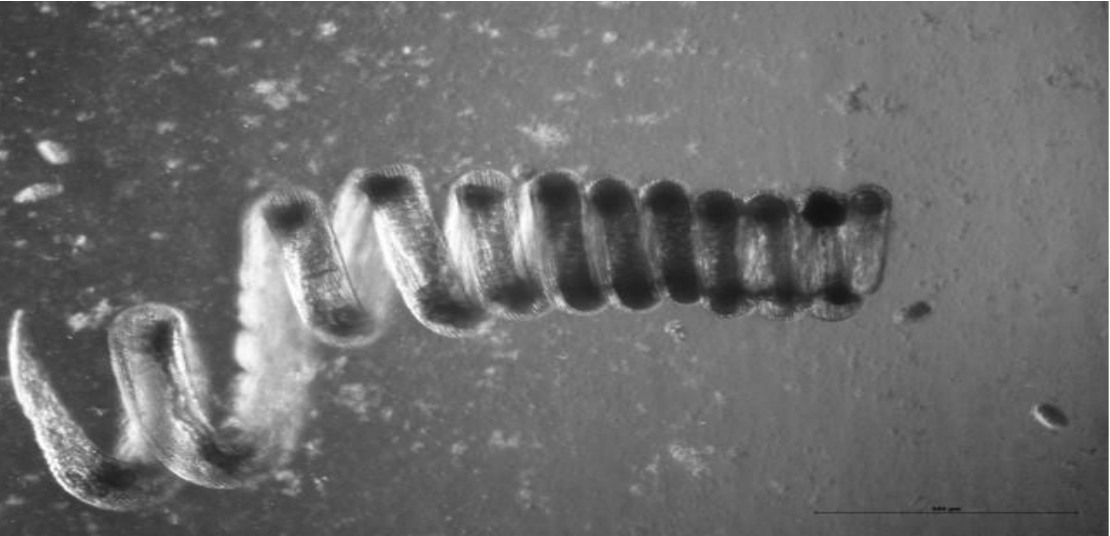
Figure 1. A female adult H. polygyrus. In vivo the worm wraps itself around intestinal villi which may help to prevent expulsion by peristalsis. Photo: K. Donskow-Lysoniewska.